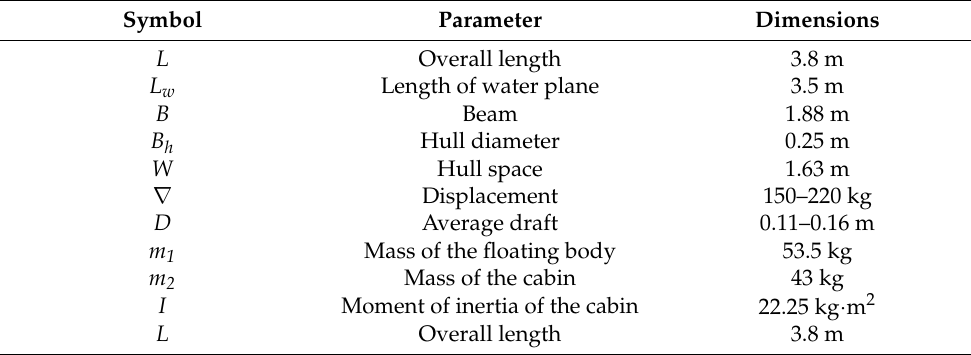
Table 1. Structure size of the designed rescue vessel.